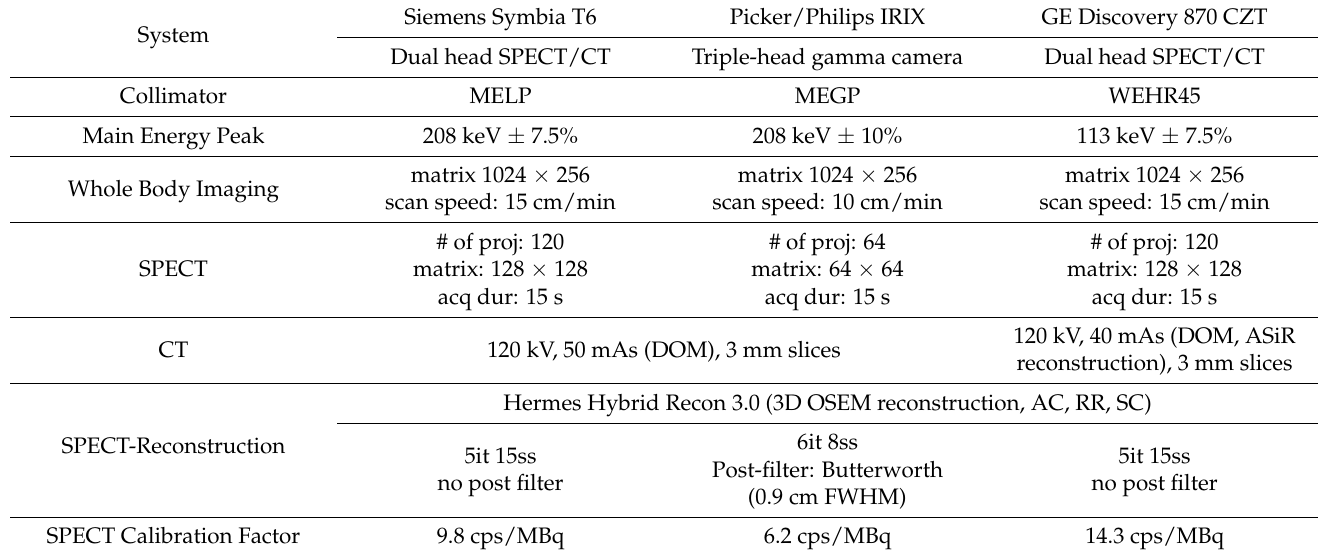
Table 2. Overview of gamma cameras used and the specific acquisition and reconstruction